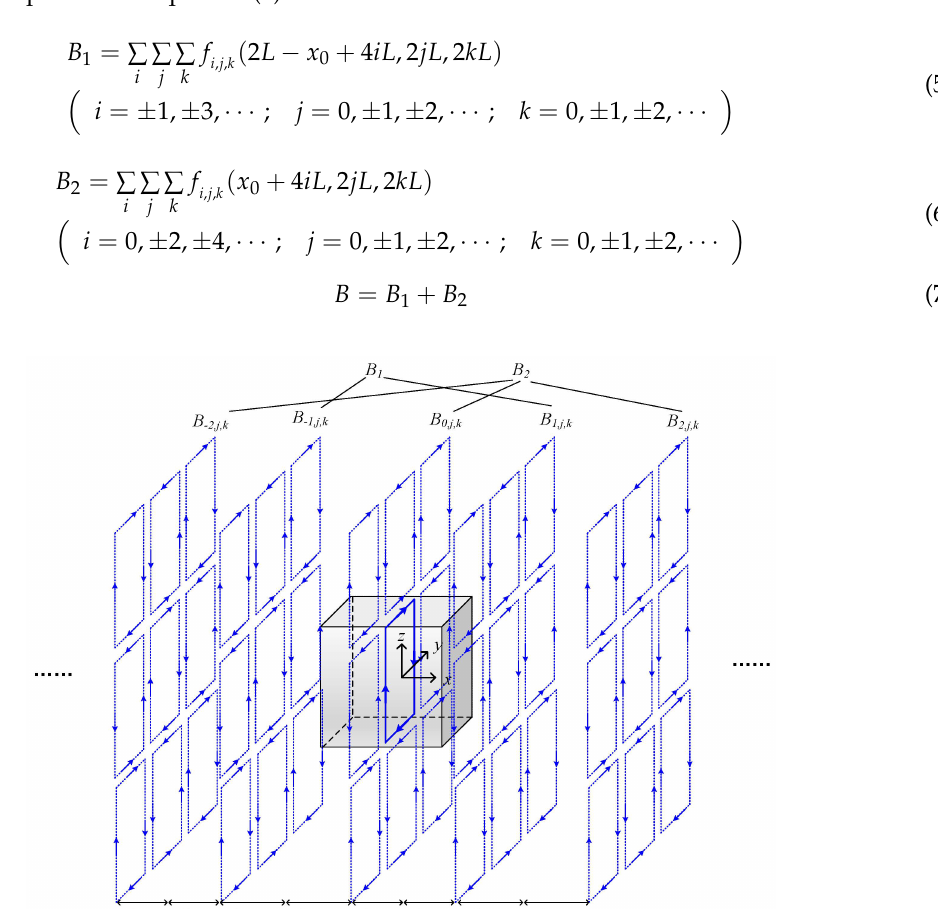
Figure 3. Image coils created for boundary conditions in in xy , xz , and yz